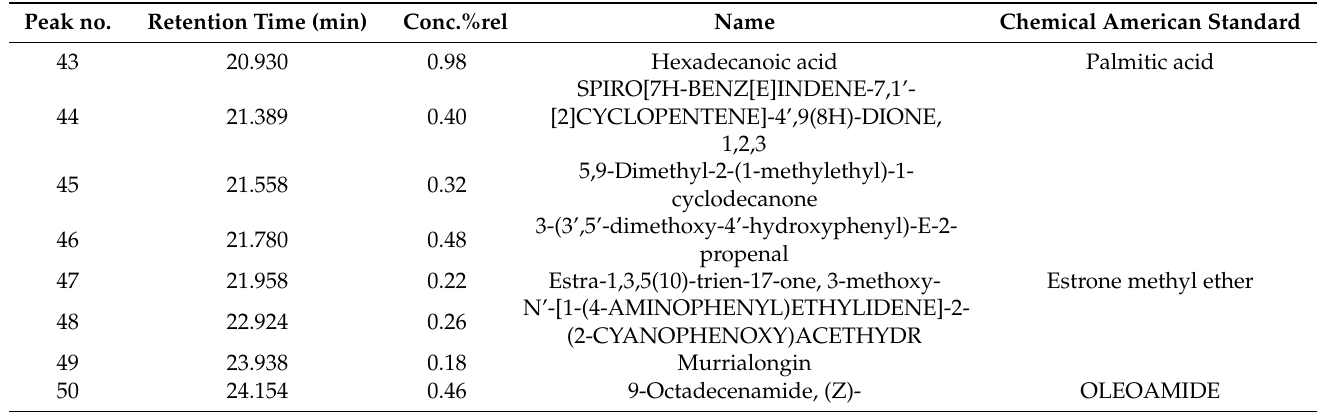
Table 9. Chemical content of jabon wood according to EDX analysis.